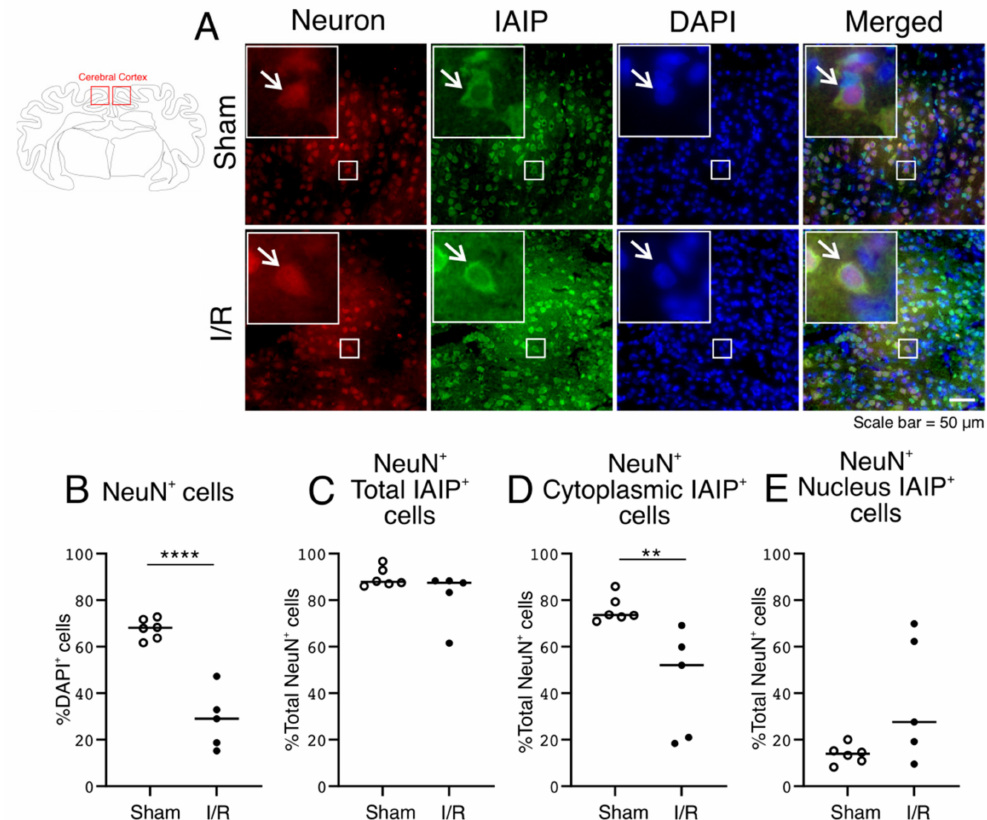
Figure 3. Subcellular localization of IAIPs in neurons in the cerebral cortex. Schematic diagram of a sheep brain indicates the regions from which cerebral cortical samples were taken. ( A ) Repre- sentative images of neurons (Red), IAIPs (Green), DAPI-positive cells (Blue), and merged double immunostaining in the cerebral cortex of fetal sheep. Magnification, 40 × . Each inset contains the extended images. Scale bar = 50 µ m. Arrows indicate the same cell. ( B ) Quantification of NeuN positively stained cells. NeuN-positive cells plotted as percentages of DAPI-positive cells on the y -axis for the Sham (open circles) and I/R (closed circles) groups on the x -axis. ( C – E ) Quantification of IAIP positively stained neurons. IAIP-positive NeuN-positive cells expressed as a percentage of NeuN-positive cells on the y -axis for total ( C ), cytoplasmic ( D ), and nuclear ( E ) compartments plotted for the Sham (open circles) and I/R (closed circles) groups on the x -axis. Values median and scattergrams. ** p < 0.01, **** p <